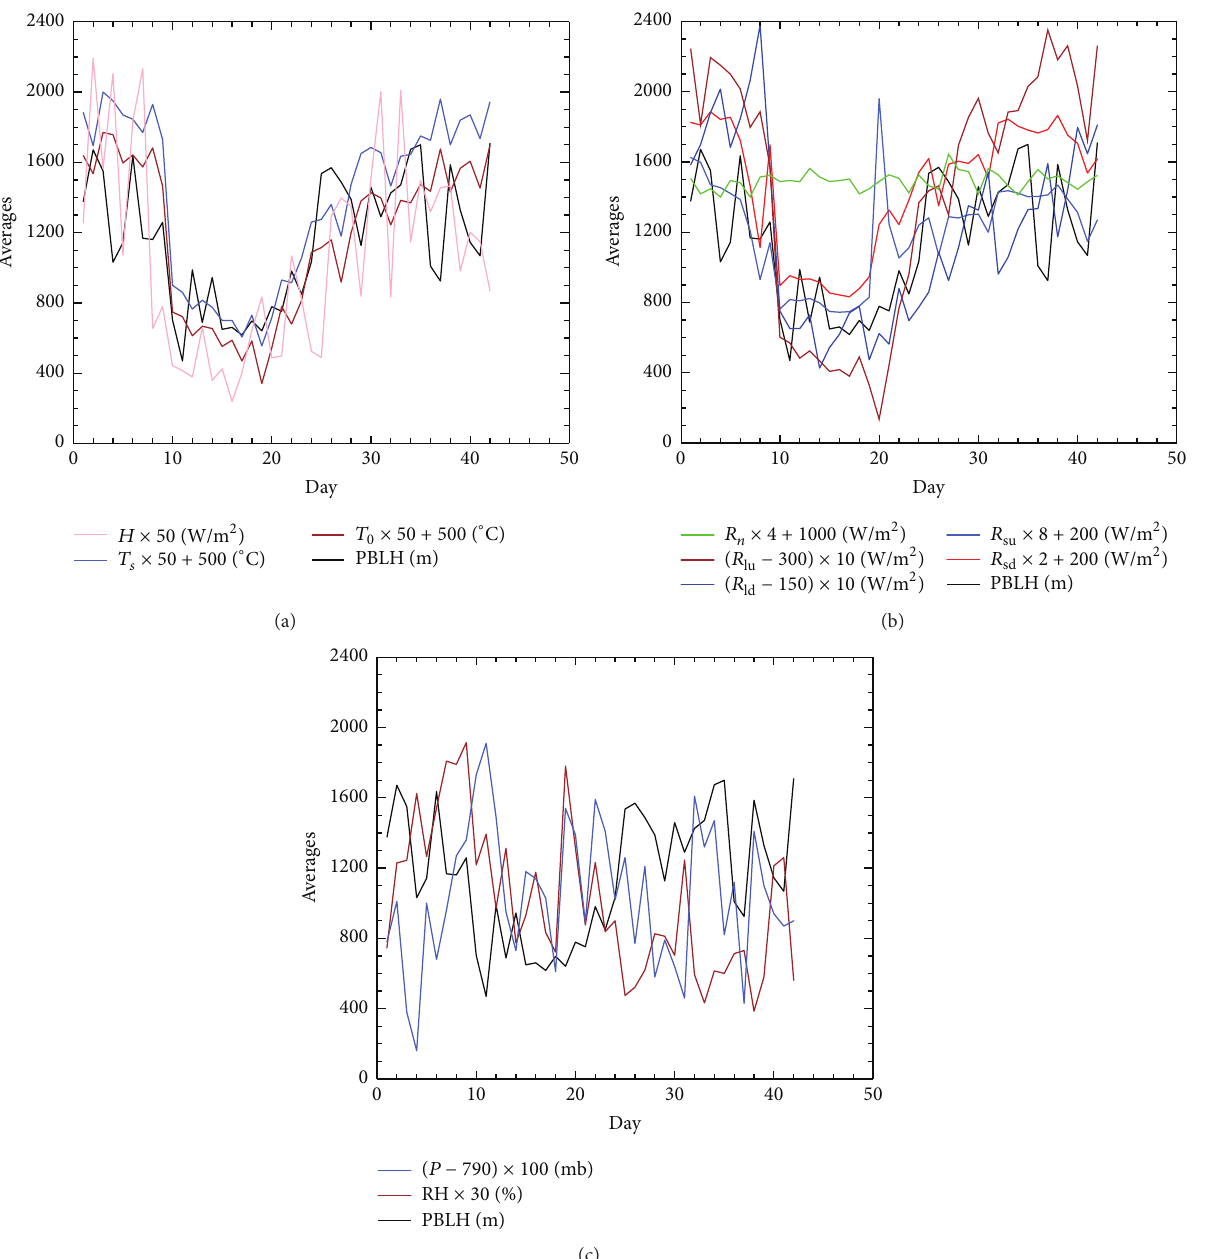
Figure 1: Distributionof daily averages of atmosphericvariables and boundary layer height for42 selected days (seeTable 2 forabbreviations).